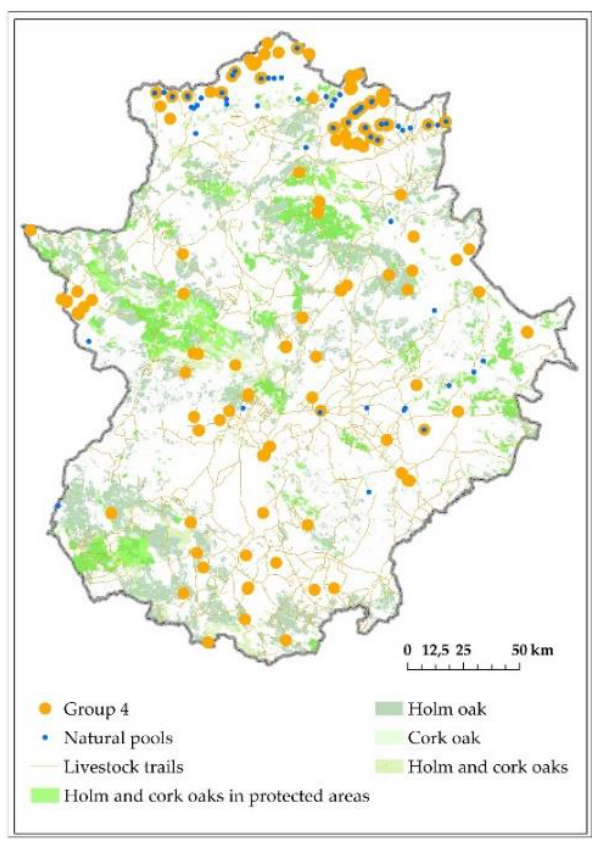
Figure 10. Group 4.